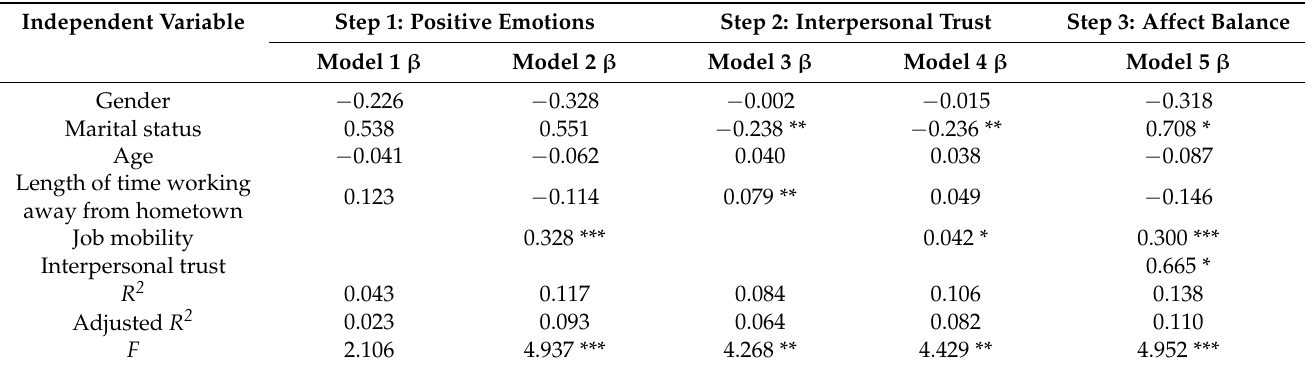
Figure 1. The mediating effect of interpersonal trust in the relationship between job mobility and positive affect. Note. * p < 0.05, *** p < 0.001. Table 5. Multivariate hierarchical regression analysis of the impact of interpersonal trust and job mobility on affect balance ( n =